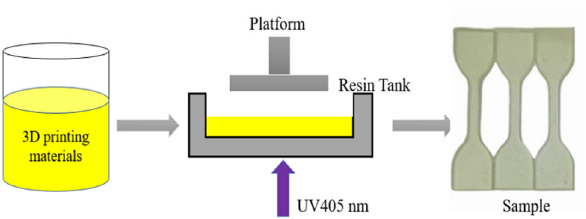
Figure 3: Curing process of 3D printing